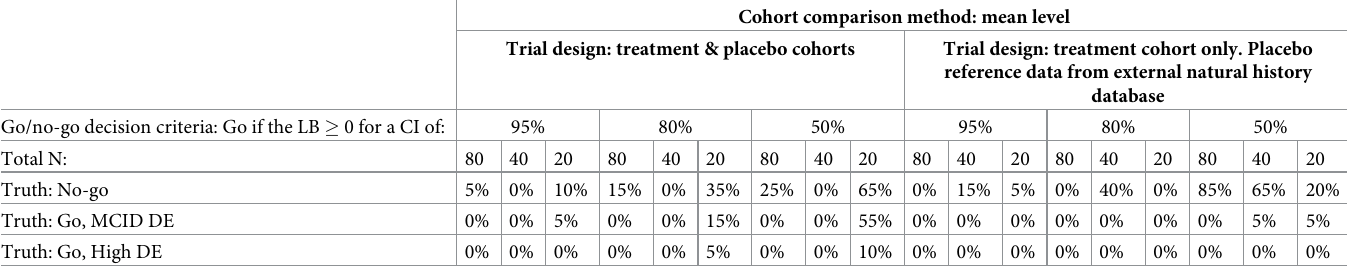
Table 3. Performance of the frequentist analysis go/no-go decisions across trial designs and analysis methods. Go/no-go decisions were made at frequentist confidence levels of 95, 80 and 50%. Cohort comparison method: mean level Trial design: treatment & placebo